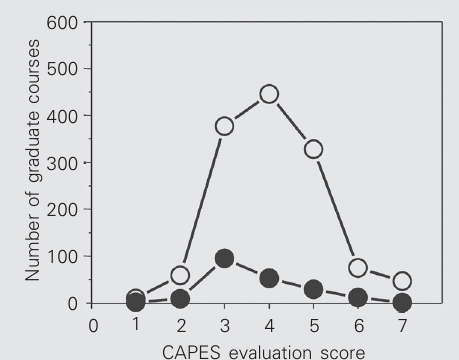
CAPES evaluation score